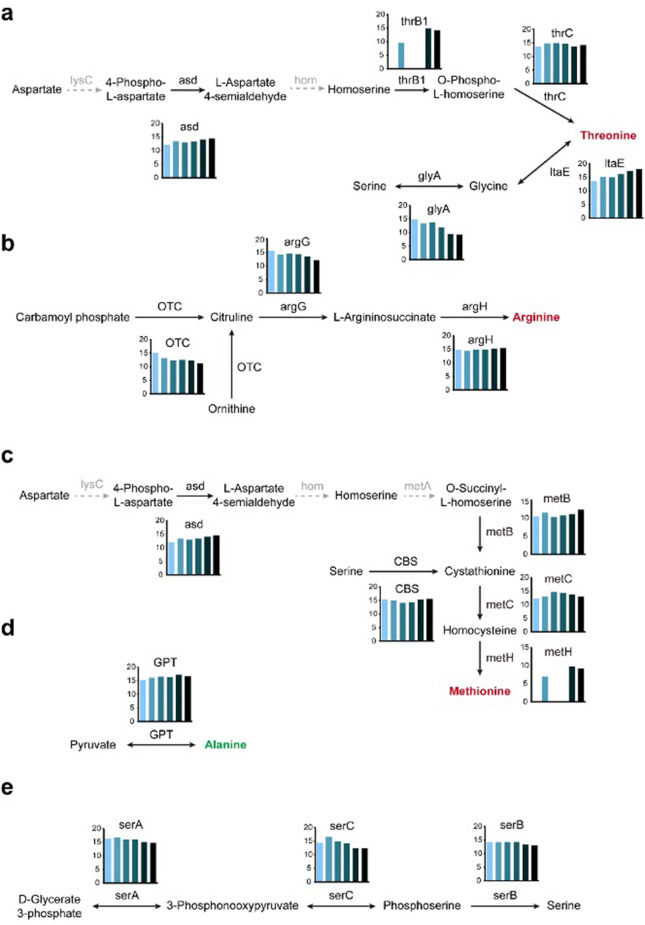
Activation of amino acid biosynthetic pathways.Threonine (A), arginine (B), and methionine (C) are generally regarded as essential amino acids in C. chilonis, while alanine (D) and serine (E) are non-essential amino acids. The gray arrows mean the gene loss. Gene expression at different development stages (from left to right, early larvae, later larvae, female pupa, male pupa, female adult, and male adult) as measured by quantification of transcription levels (log2FPKM) is shown in the histograms.